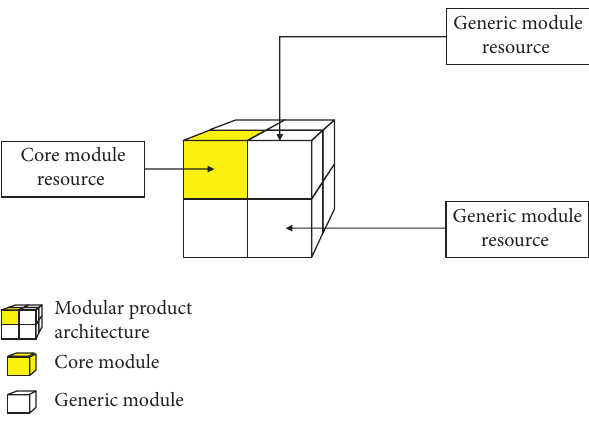
Figure 1: Linkage between innovation resources and modular product